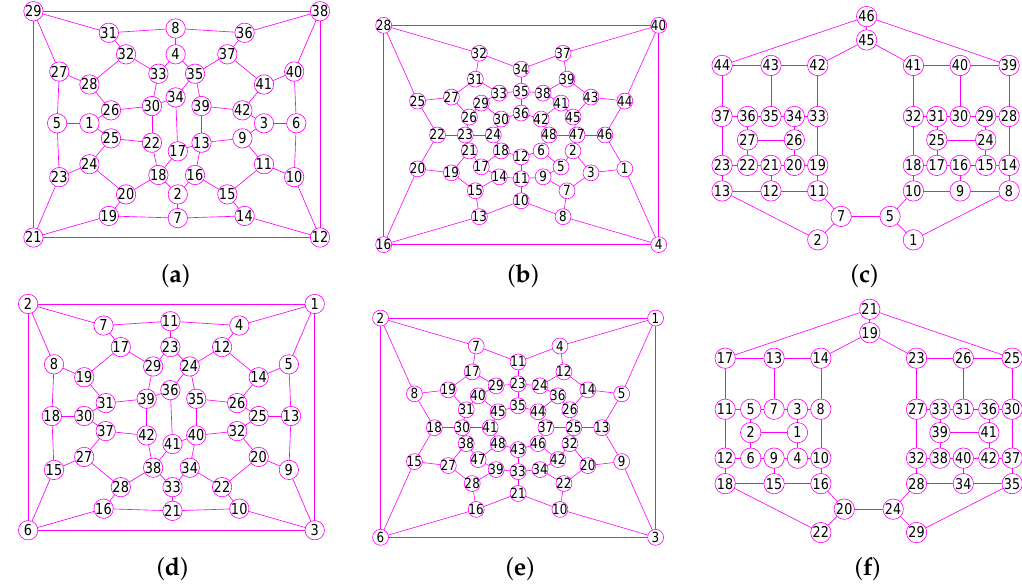
Figure 20. The TopMost graphs of three graphs G 31 , G 32 and G 33 . ( a ) The Wiener-Araya graph G 31 of 42 vertices and 67 edges; ( b ) The Zamfirescu graph G 32 with 48 nodes and 76 edges; ( c ) The Faulkner-Younger graph G 33 of 42 nodes and 62 edges; ( d ) The TopMost graph of G 31 ; ( e ) The TopMost graph of G 32 ; ( f ) The TopMost graph of G 33